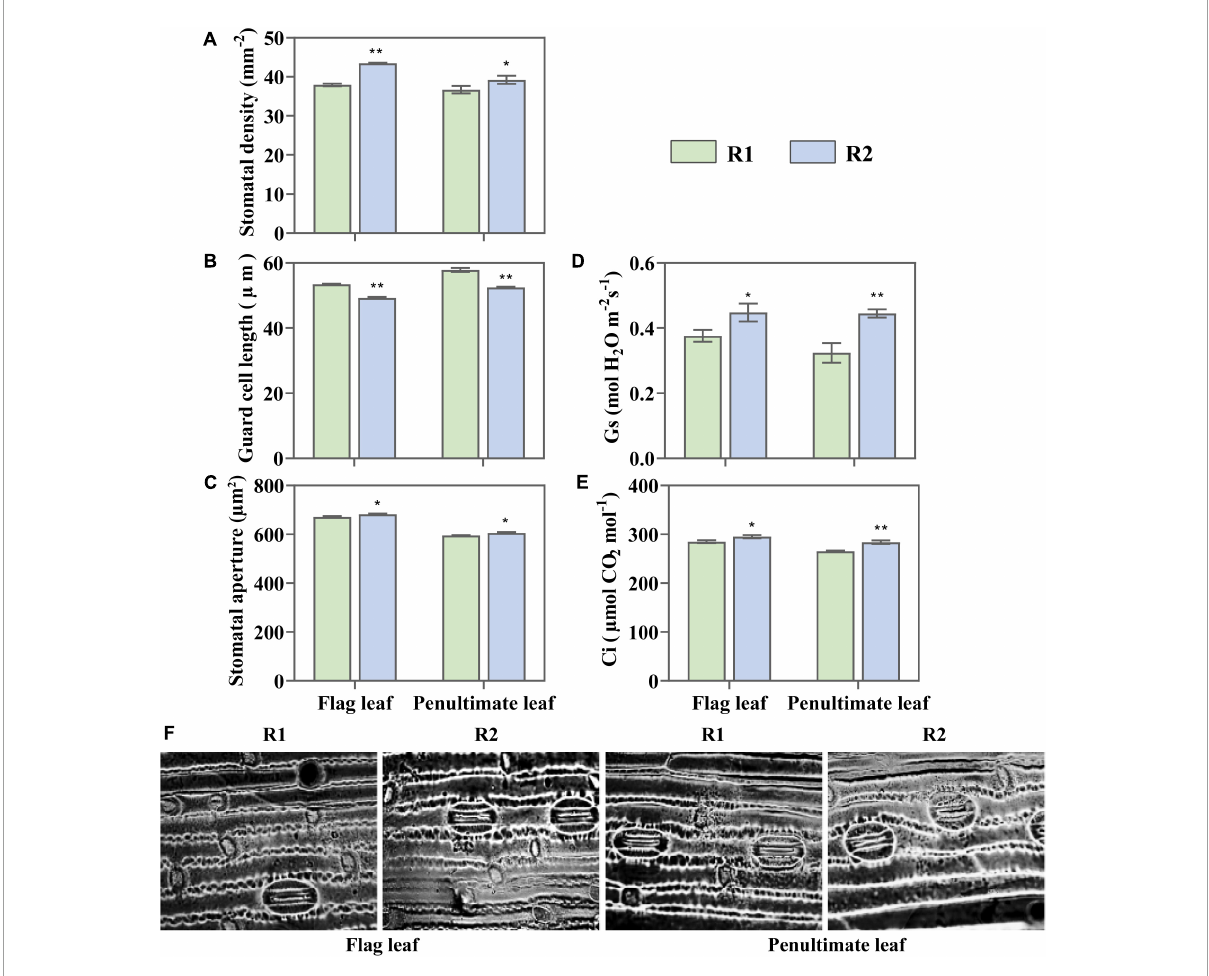
FIGURE8 Change in stomatal density (A) , guard cell (B) , stomatal aperture (C) , stomatal conductance (Gs) (D) , and intercellular CO 2 concentration (Ci) (E) in the flag and penultimate leaves at anthesis under different row spacing treatments. (F) Optical microscopic images of stomata under × 40 objective lens. Results expressed as mean ± standard deviations (SD); Error bars represent SD. Significant differences marked by asterisks (* p < 0.05; ** p <